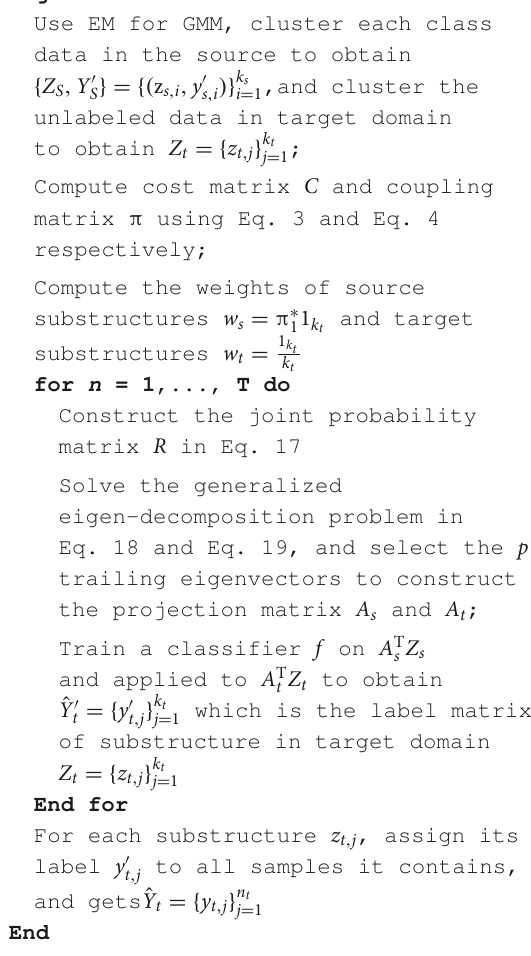
Algorithm 2. Substructural Joint Probability Distribution Adaptation with Bi-Projection Metrix